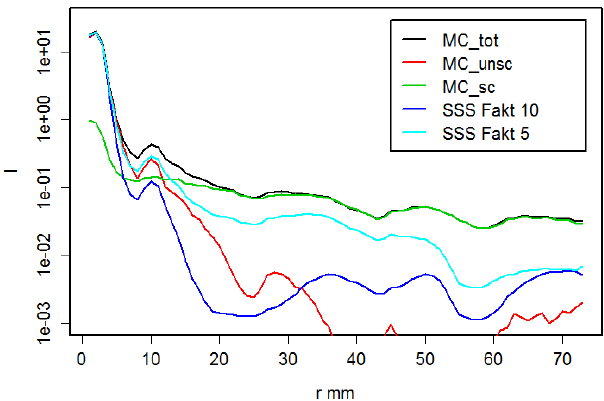
Figure 4. Intensity I vs. radial distance r from the central line source of images, in dependence of the type of scatter correc- tion (MC_tot: total true coincidences tot, MC_unsc: only unscat- tered coincidences unsc, MC_sc: only scattered coincidences sc, SSS_Fakt_10/SSS_Fakt_5: all true coincidences (tot) with SSS cor- rection and scaling factors 10 and